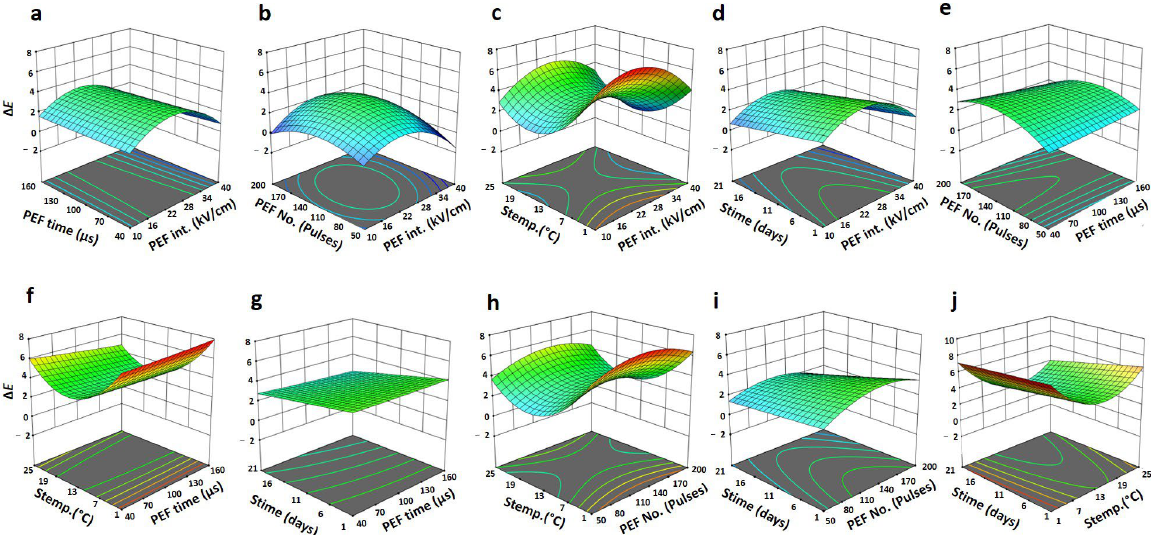
Figure 4. Response surface plots of total color change ( ∆ E) of Barhi dates as a function of PEF time and PEF intensity ( a ), PEF number of pluses and PEF intensity ( b ), storage temperature and PEF intensity ( c ), storage time and PEF intensity ( d ), PEF number of pulses and PEF time ( e ), storage temperature and PEF time ( f ), storage time and PEF time ( g ), storage temperature and PEF number of pulses ( h ), storage time and PEF number of pulses ( i ), and storage time and storage temperature ( j ).